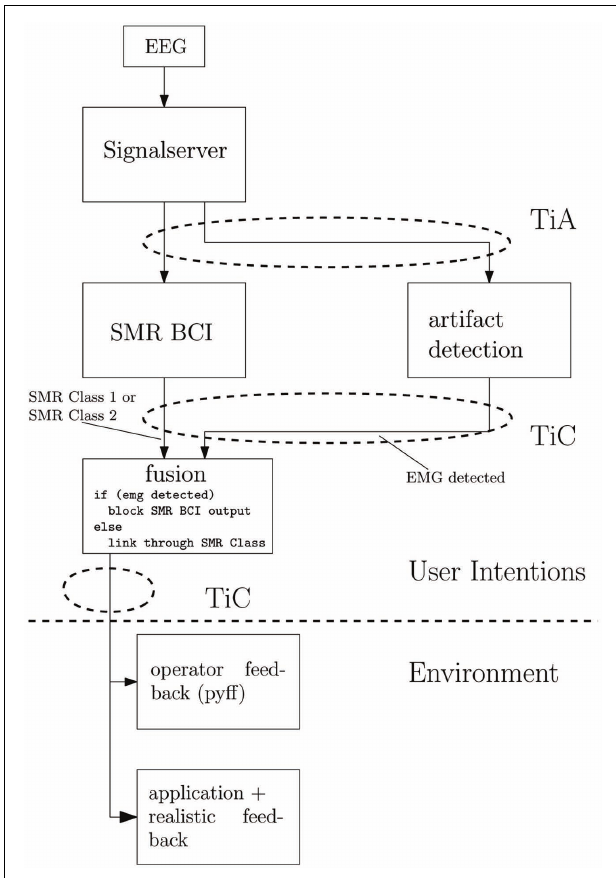
FIGURE 6 | Schema of the hybrid BCI demonstration setup. Each block indicates a computer, connected over a LAN connection usingTiA andTiC.